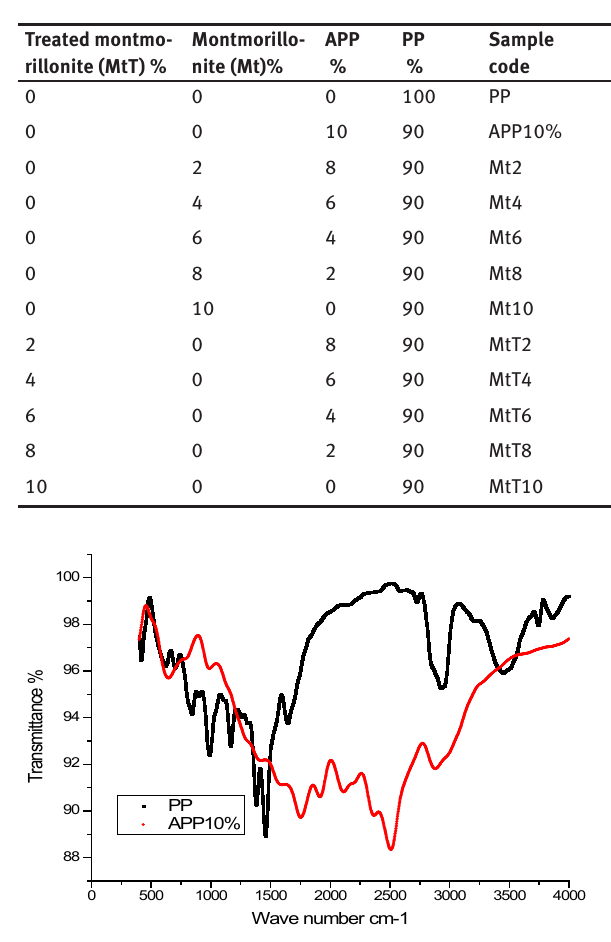
Figure 1: FTIR for PP and